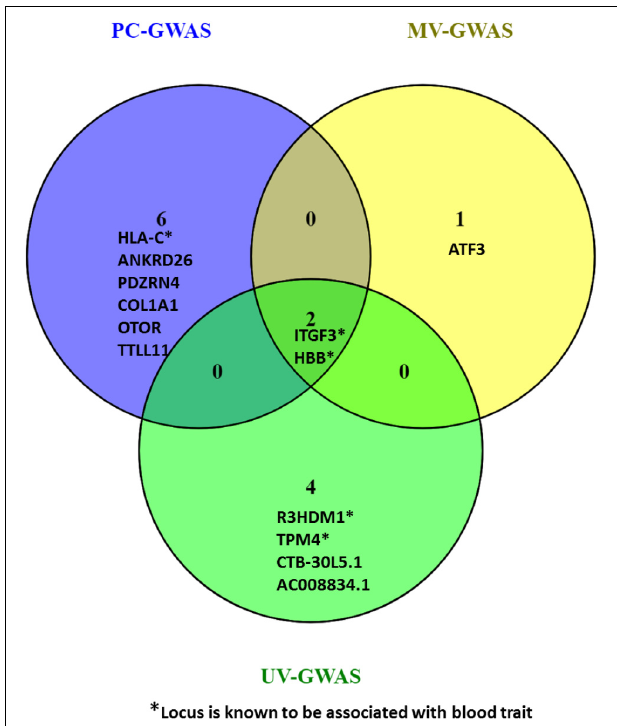
FIGURE 9 | Venn diagram comparing the loci found by PC-GWAS and MV-GWAS in comparison with UV-GWAS. Two known loci HBB and ITFG3 were identified all the three methods. Two novel intergenic variants identified by UV-GWAS not